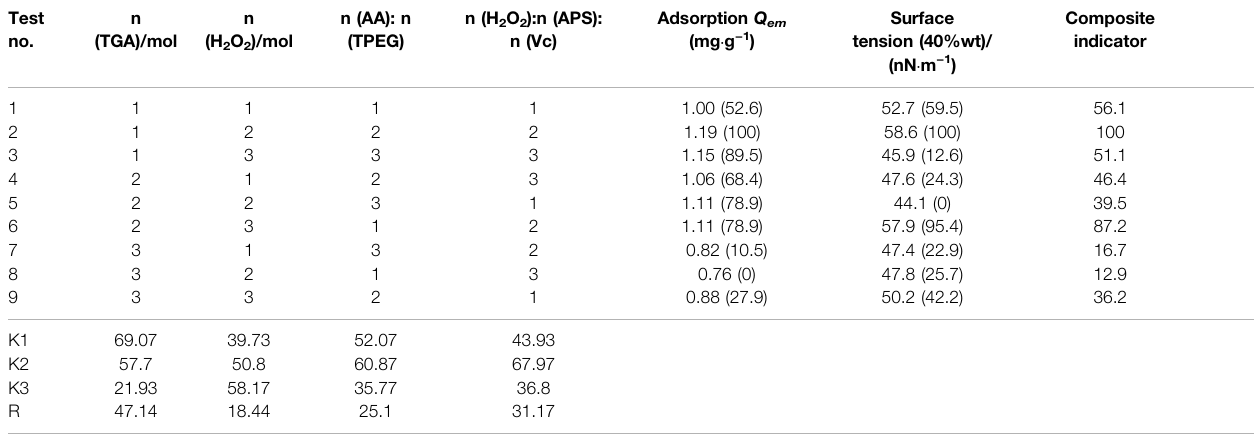
TABLE 3 | Results of factorial design.